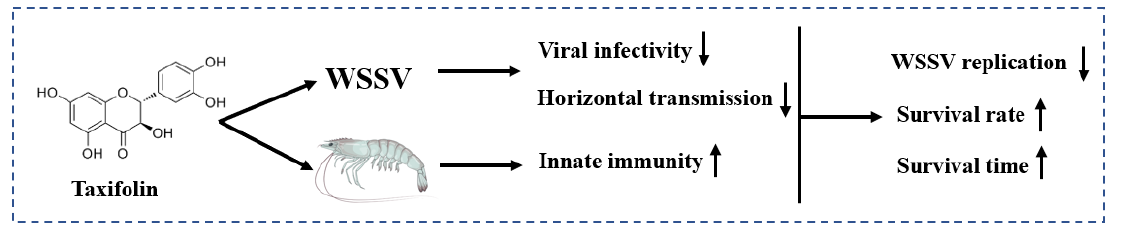
Figure 9. Schematic illustration of anti-WSSV activity of taxifolin in shrimp. ↑ up-regulation; ↓ down-regulation.